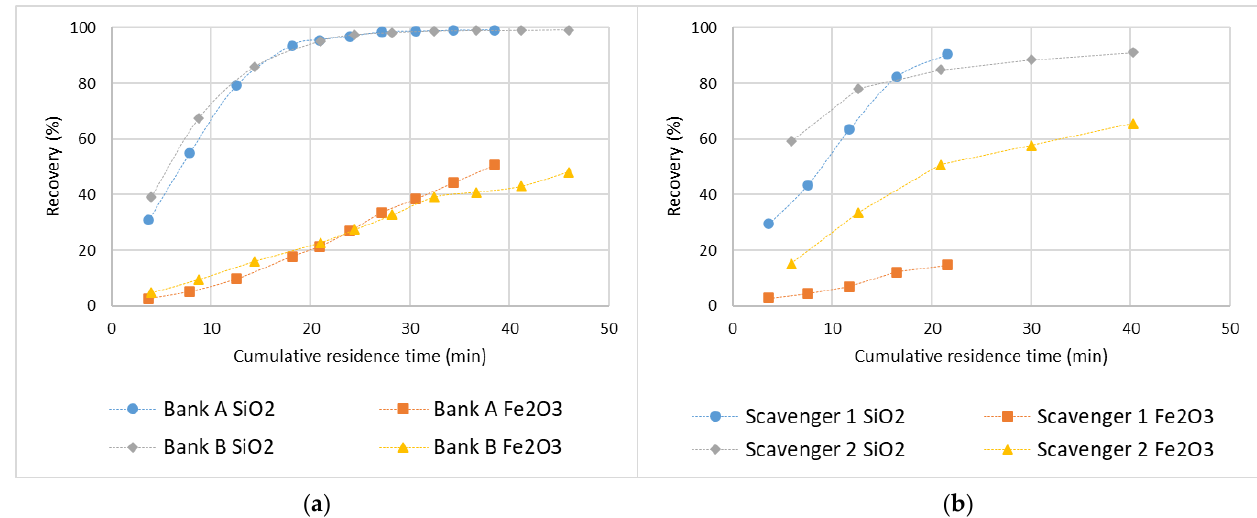
Figure 6. Hematite and quartz recovery as a function of the cumulative bank residence time for ( a ) roughers, cleaners, and recleaners of bank A and B, and ( b ) scavenger 1 and 2.